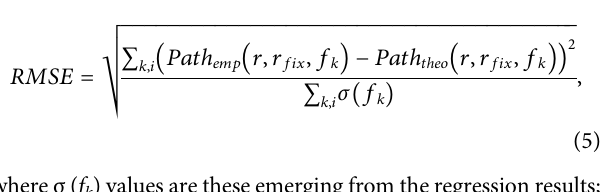
Frontiers in Earth Science |